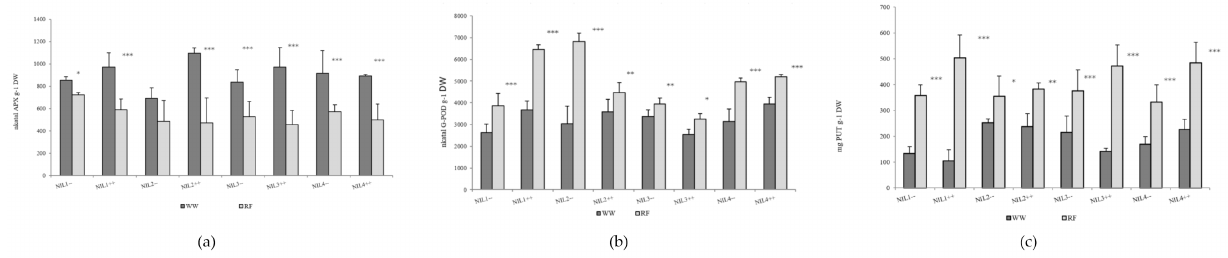
Figure 1. Changes in the ( a ) ascorbate peroxidase (APX) and ( b ) guaiacol peroxidase (G-POD) enzyme activity and ( c ) in the putrescine (PUT) content in the flag leaf in the well-watered (WW) and rain-fed (RF) treatments. *, ** and *** denote significant differences between the treatments at the p < 0.05, 0.01 and 0.001 levels of probability, respectively